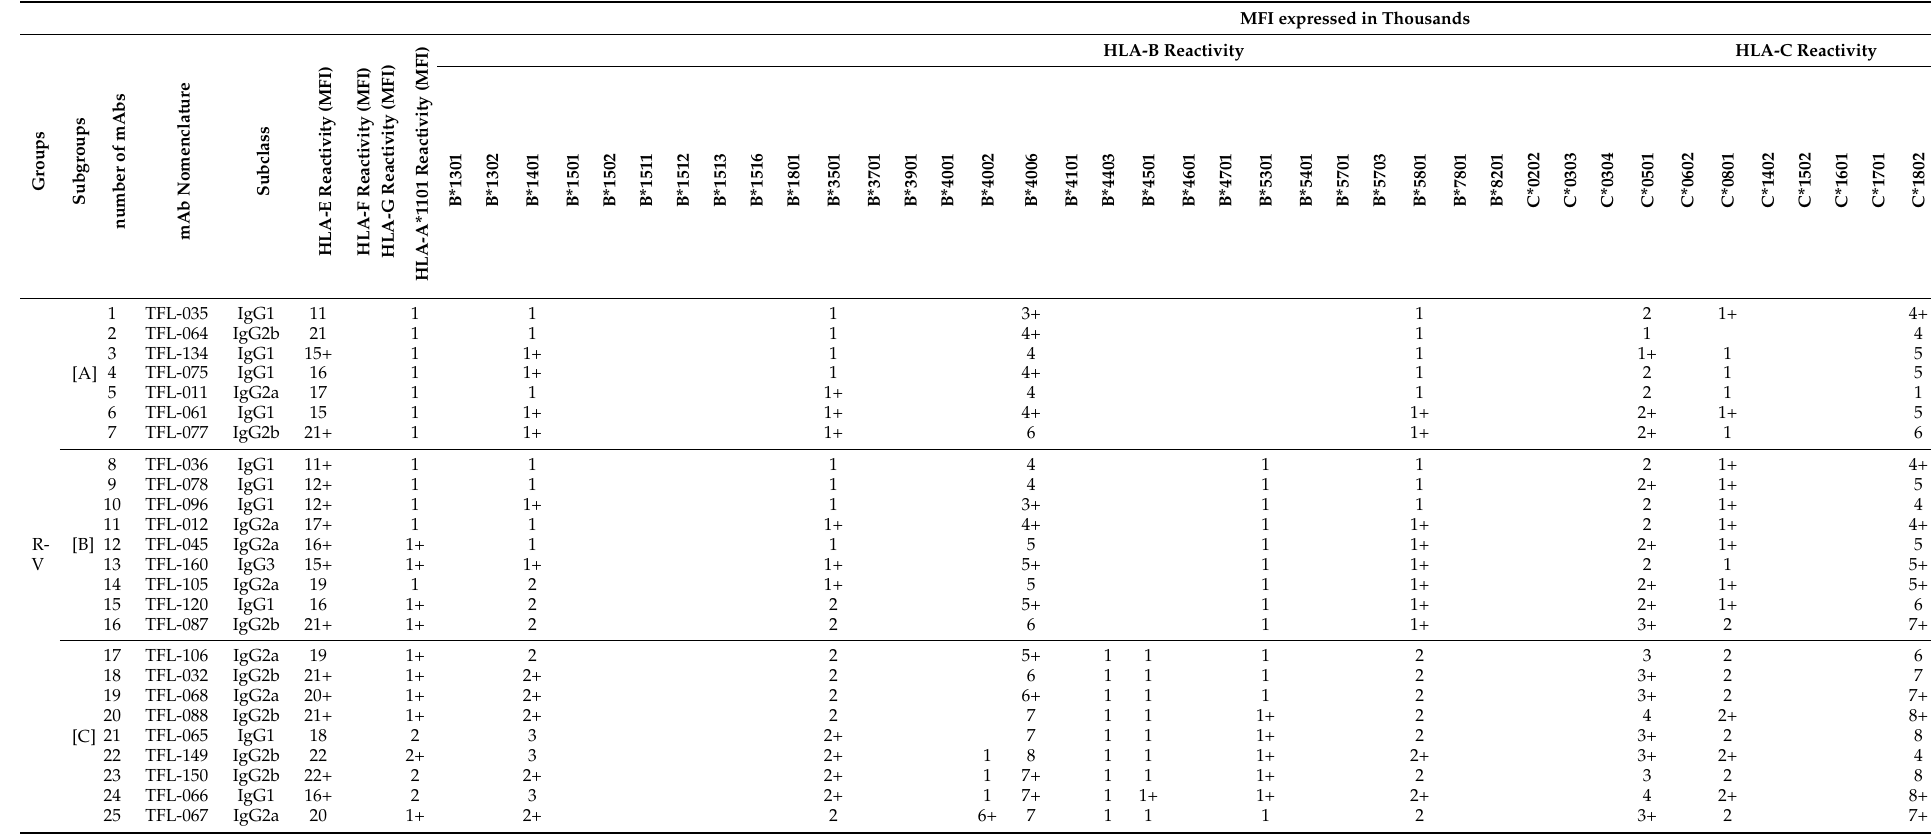
Table 5. HLA-E R mAbs: HLA-F and HLA-G non-reactive but reactive to HLA-A*1101, HLA-B, and HLA-C